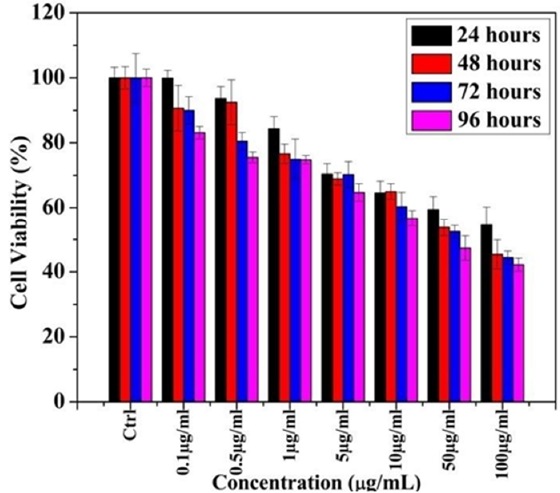
Figure 2. MTT assay of cell cytotoxicity in PC 12 cell lines using Ag-T- NPs. From the MTT assay, it was observed that, at 1 µg/mL, cell viability reduces appre- ciably after 24 hours (h) and remains unchanged for 72 and 96 h. At 24 h, cell viability decreases with an increased concentration of NPs. The same trend was observed for 48, 72, and 96 h of exposure time. Concentrations that were higher than 5 µg/mL showed a reduced cell viability compared toremaining concentrations. This finding suggested that cytotoxicity induced by the Ag-T-NPs is time- and concentration-dependent. 2.3. Significance of Physical Parameters on Cytotoxicity 2.3.1. Role of the Selected Input Features on the Cytotoxicity Ag-NPs show a cytotoxic nature, and the parameters that affect the cytotoxicity are particle size, capping agents, reducing agents, zeta potential, shape, chemical composi- tions, exposure time, dosage, and the wavelength of NPs. 2.3.2. Effect of Particle Size Particle size is reported to be a key parameter for deciding the cytotoxic nature of Ag- NPs [30]. It is evident from the literature that particle size affects the surface area-to-vol- ume ratio and surface reactivity of nanoparticles [31–33]. One possible reason could be that the increased surface area of nanoparticles increases the number of surface atoms or molecules in an exponential trend, which offers high reactivity [34]. Also, different particle sizes show distinct interactions with differentcell lines [35]. It is evident from the research that, as the particle size decreases, the cytotoxicity increases. This statement can be vali- dated by Carlson et al., who synthesized 15 nm and 55 nm hydrocarbon-coated Ag NPs. They observed that the generation of reactive oxygen species (ROS) is higherfor 15 nm as compared to 55 nm Ag NPS exposed on macrophage cell lines [31]. Similar results were found in the work of Liu et al., where 5 nm Ag-T-NPs proved to be more toxic than 20 and 50 nm Ag-NPs on four different cell lines (A549, HEPG2, MCF-7, and SGC-7901) [21]. One possible reason for this could be the easy internalization of smaller particle sizes into cell membranes. 2.3.3. Effect of Capping Agent The capping of an electrostatic layer is required to curtail the agglomeration and sta- bilize Ag-NPs. Capping agents help modify the surface chemistry of NPs by stabilizing them, offering a definite shape, and reducing the Ag + ions. From the existing literature, it